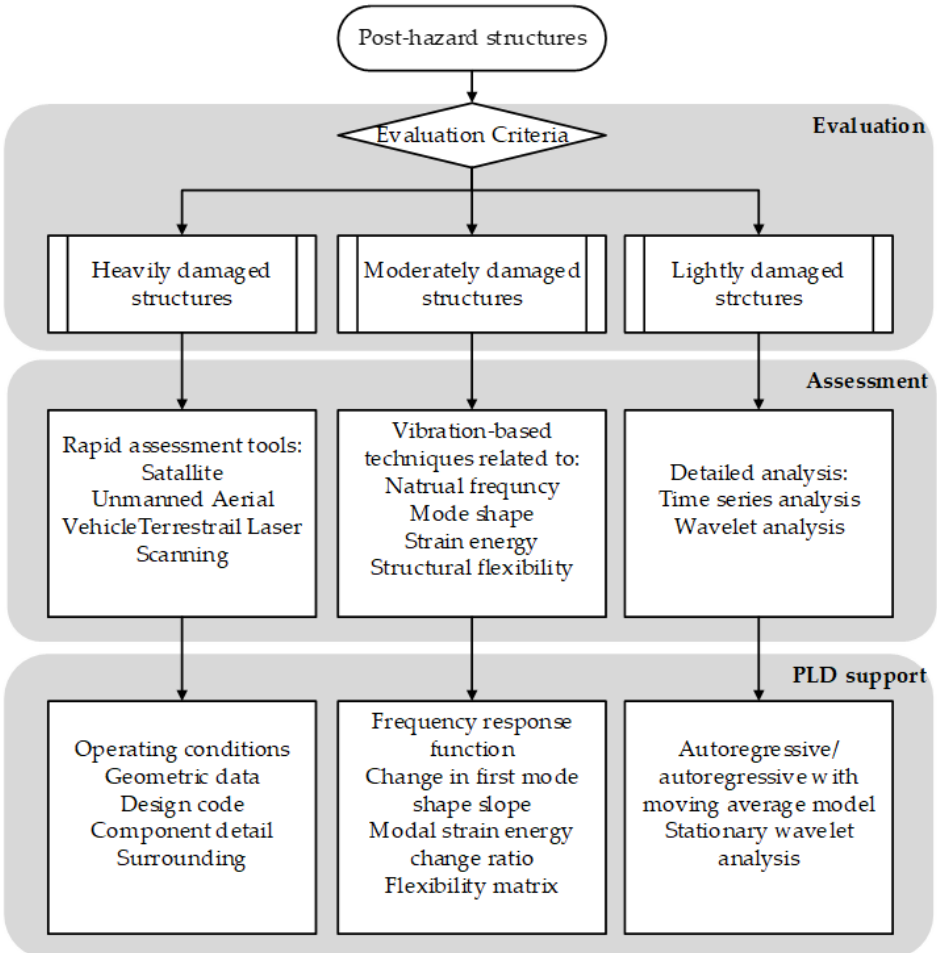
Figure 1. Post-hazard structural damage evaluation and assessment framework .